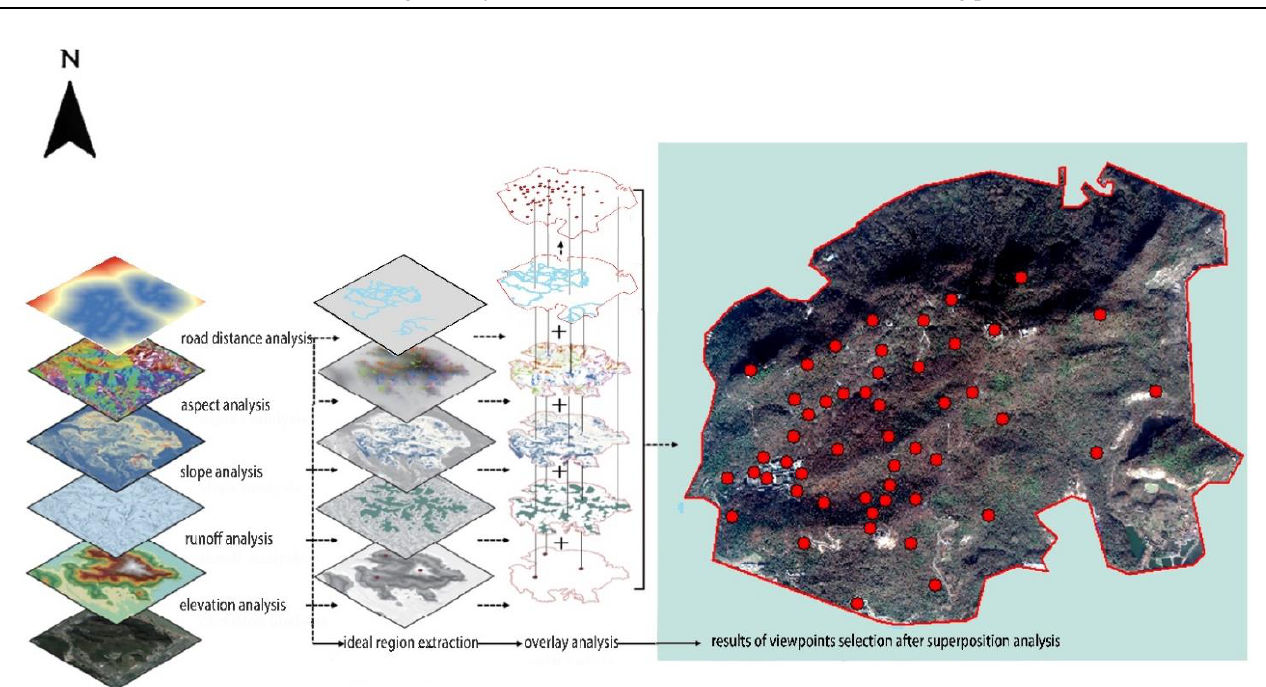
Figure 3. Flowchart of viewpoint selection in the study area based on ArcGIS. Table 2. Presentation of some information from the sample sire survey.